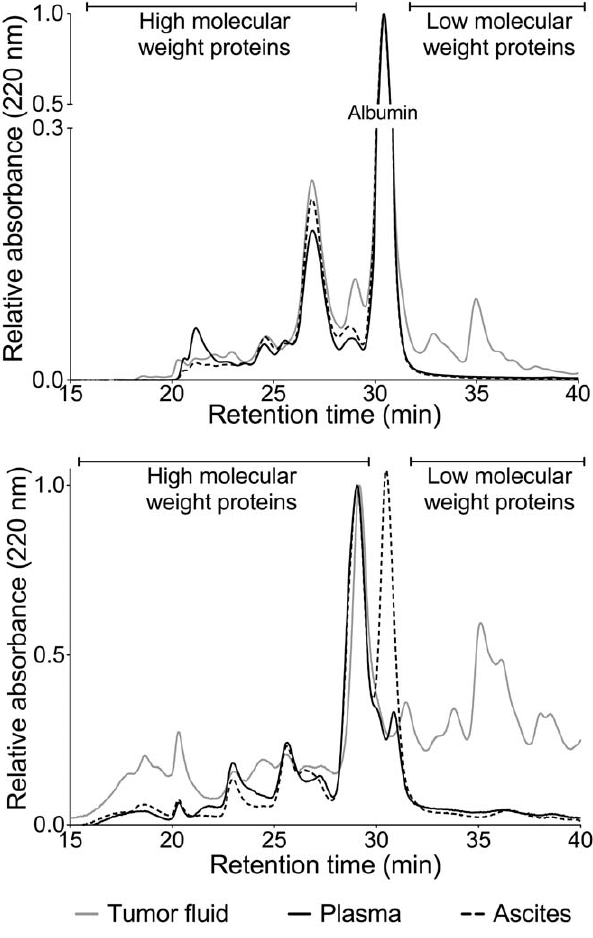
Figure 4. Chromatographic evaluation of tumor fluid, plasma and ascites by size-exclusion chromatography. A: Size exclusion- chromatography of native tumor fluid, plasma and ascites, results are normalized in respect to albumin. As expected, albumin was a major constituent, and all three samples were dominated by major plasma proteins. The chromatogram for tumor fluid indicates that there were some low molecular weight proteins present in tumor fluid that were not found in ascites or plasma. B: After immunoaffinity depletion of the 14 most abundant plasma proteins, the ascites and plasma samples were still similar, except from an albumin peak for ascites that can indicate incomplete depletion of albumin. Tumor fluid reveals large differences in the protein composition compared to plasma and ascites, indicating the presence of tumor specific proteins in tumor fluid. Results were normalized in respect to the peak at a retention time of 29 minutes.